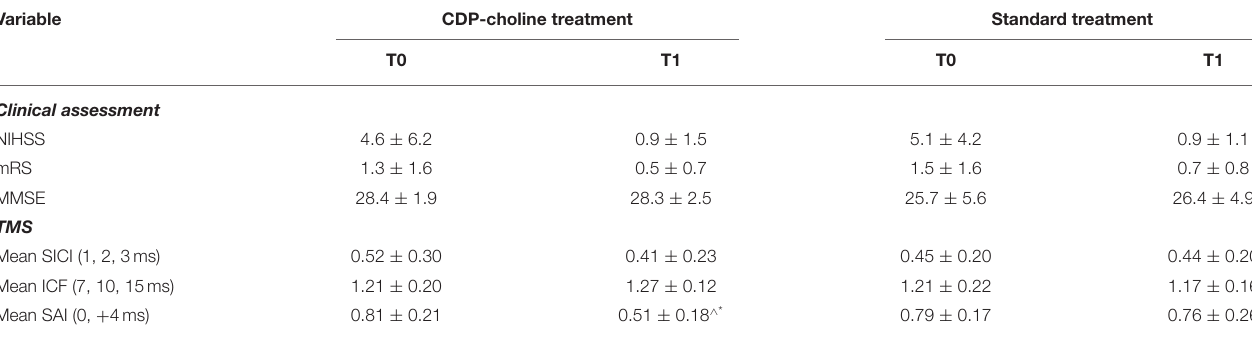
TABLE 2 | Clinical and neurophysiological parameters of included patients before and after CDP-choline or standard treatment.